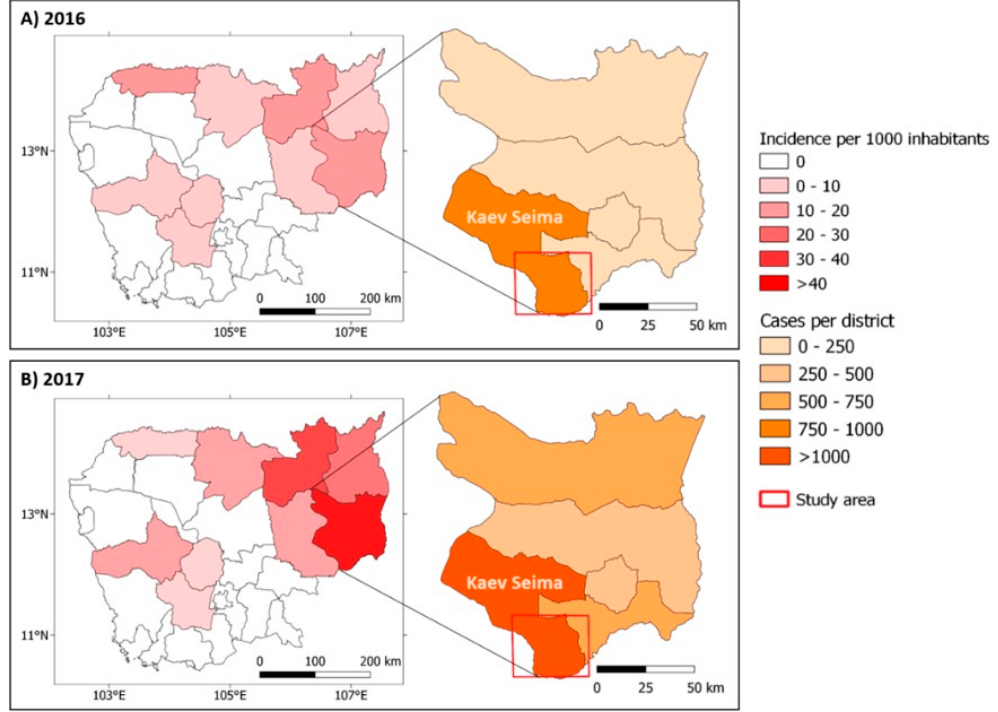
Figure 5. Incidence for 1000 inhabitants per province and number of cases per district of Mondulkiri province for years 2016 ( A ) and 2017 ( B ).